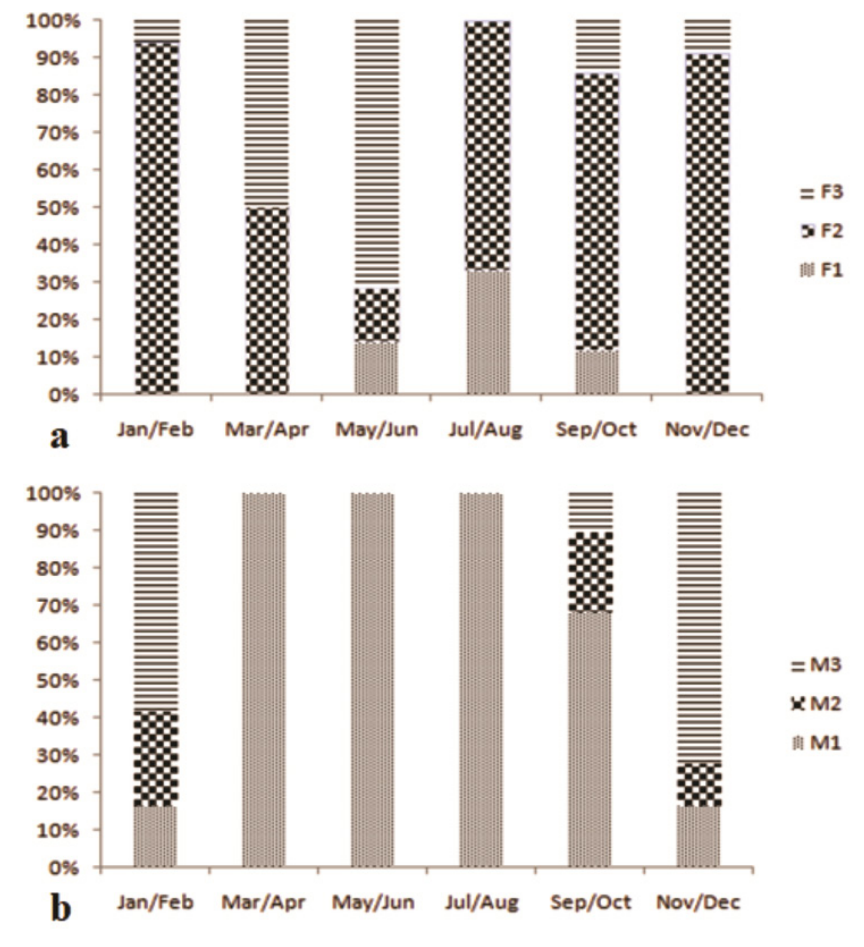
Figure 4. The bi-monthly distribution of the gonadal maturation stages of S. elegans (a) females and (b) males caught in the